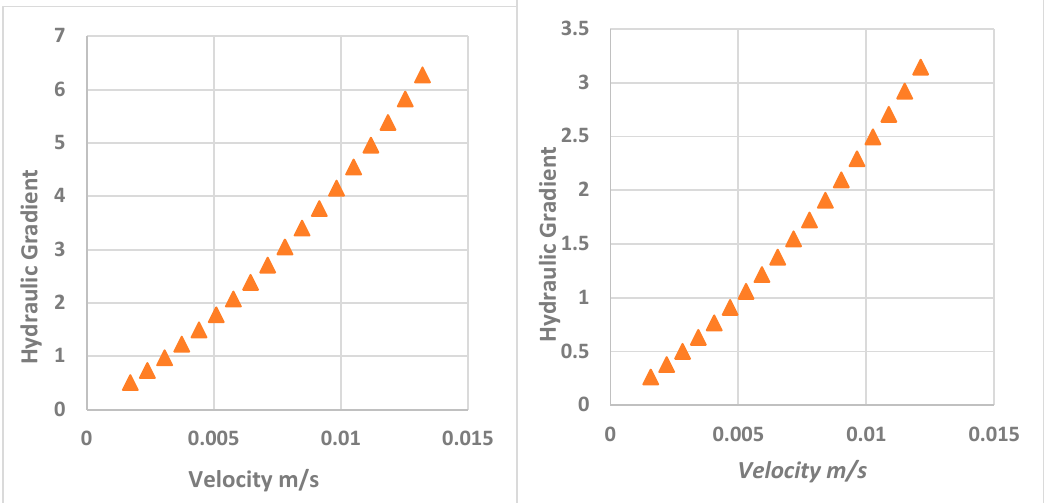
Figure 4. Hydraulic Gradient vs. Velocity for samples 1 and 2 respectively.